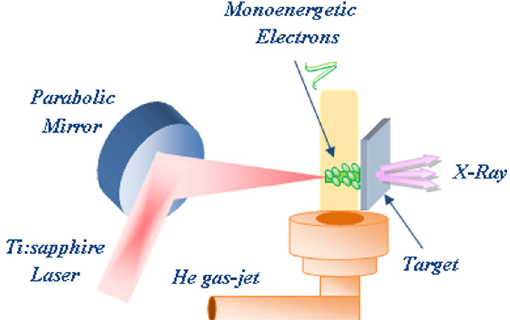
FIG. 1. A schematic of the experimental setup used for x-ray generation from a target irradiated by q -monoenergetic electrons due to laser-plasma interaction; the first part of this setup related to the q -monoenergetic electron generation is based on Ref. [20].